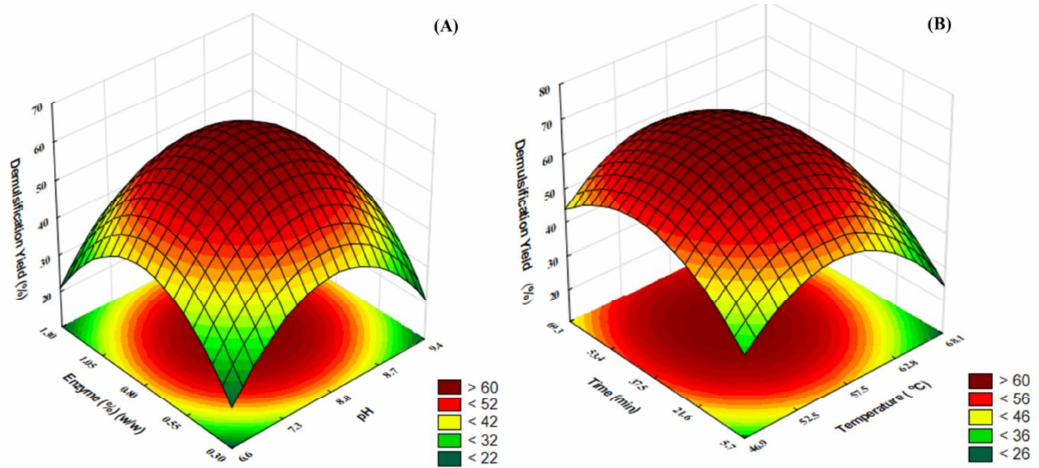
Figure3. Responsesurfaceplotforthe( A )enzymaticand( B )chemicaldemulsificationoftheAEPcream.